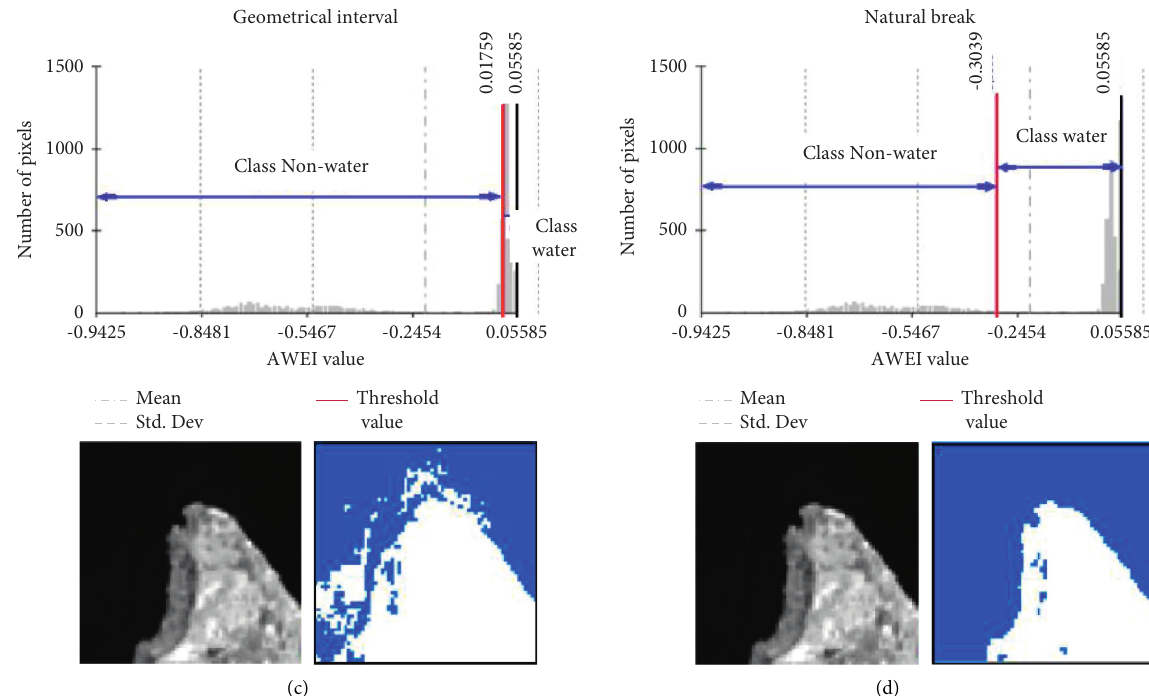
Figure 3: Automatic threshold selection procedure using geostatistical analysis approach: (a) equal interval, (b) quantile, (c) geometrical interval, and (d) natural break (an example for split scene ID: